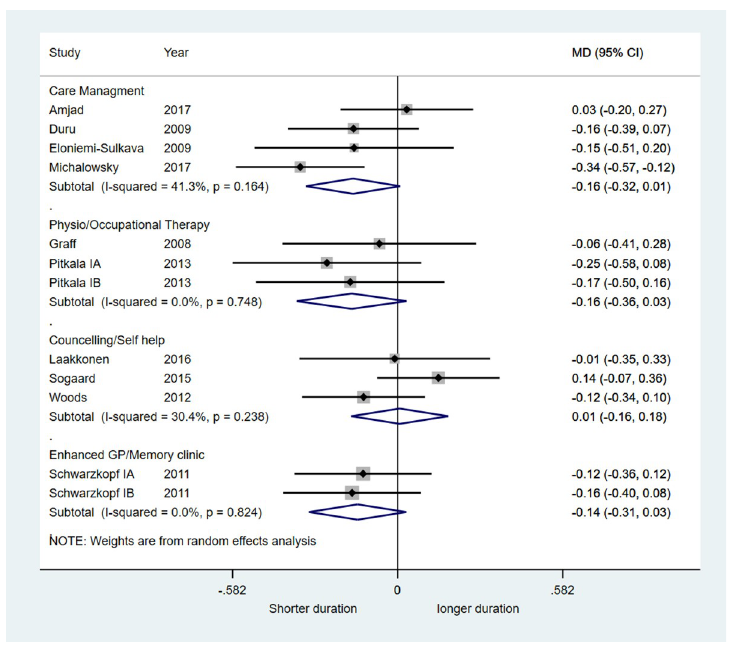
Fig 5. Forest plot of the mean difference (MD) of nights spent in hospital stratified according to type of intervention.